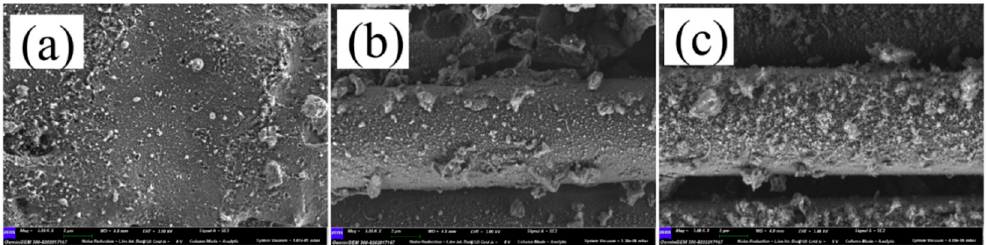
Figure 11. The etching results with di ff erent pulse overlaps by using a 50- µ m focal spot size. The areas looped with red lines showed better etching results.